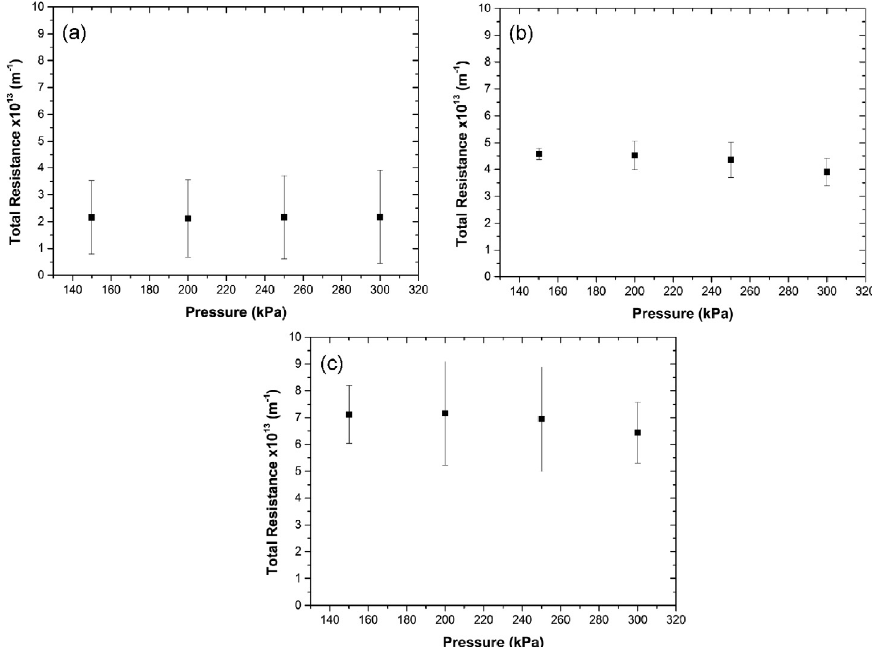
Figure 7. Analysis of the total resistance of membranes by pressure. (a) Support, (b) PA-1 and (c)